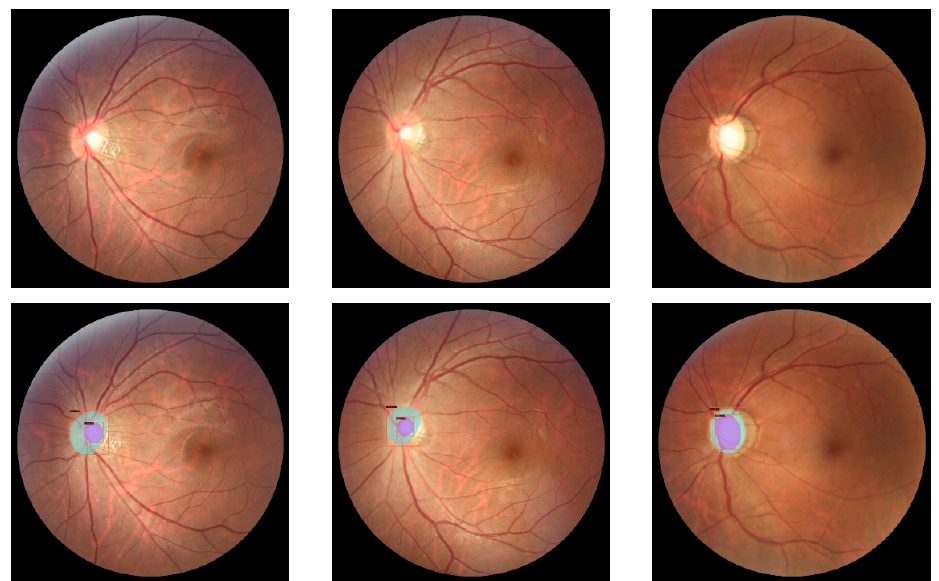
Figure 9. Output result from MS-RCNN on some images from test Refuge dataset. First row original images, second row segmented images.